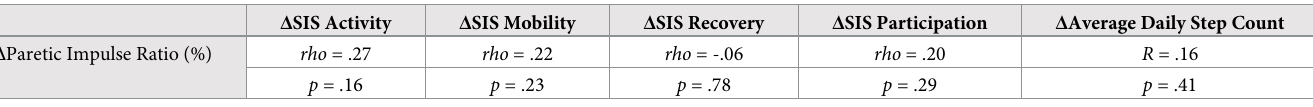
Table 4. Partial correlation of change in propulsion with change in quality-of-life (Spearman’s Rho , N = 31) and participation (Pearson’s R , N = 30) measures, con- trolling for change in comfortable gait speed.